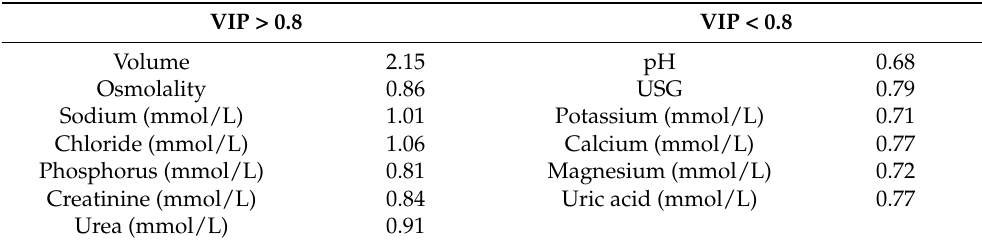
Figure 2. PLS model of the relationship between the total water intake (TWI) and urine biomarkers. ( A ) PLS model for the relationship between TWI and 13 variables. The solid line represents the line agreement, while the dashed line represents the line of best agreement; ( B ) PLS model of the relationship between the TWI and urine volume and urine osmolality. The solid line represents the line agreement, while the dashed line represents the line of best agreement. Table 3. Variable importance in the projection (VIP) coefficients for the 24 h urine hydration biomark- ers in the partial least squares (PLS) model